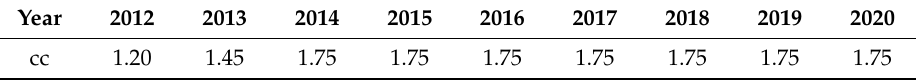
Table 8. The correction coefficient for the positive capital coefficient